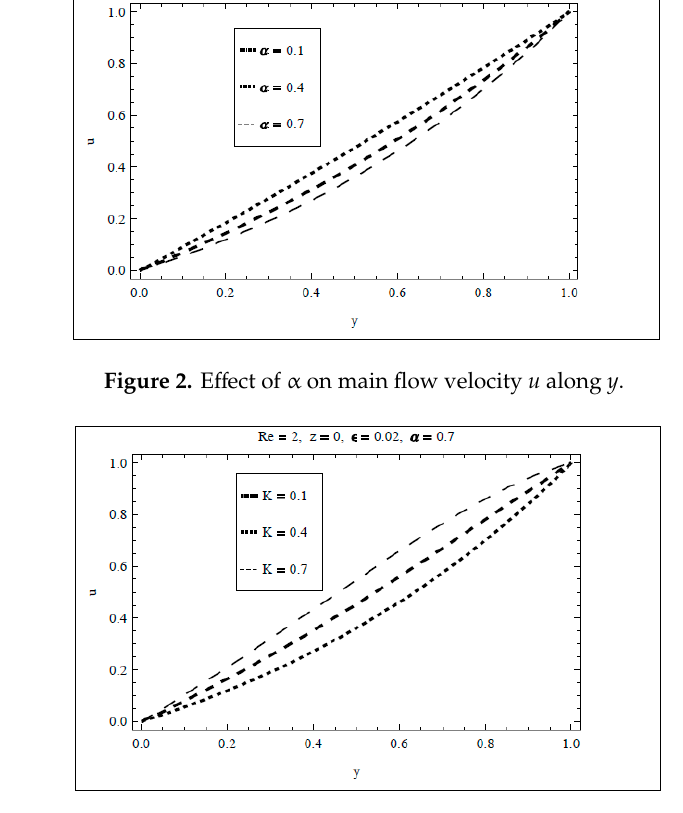
Figure 3. Effect of K on main flow velocity u along y .